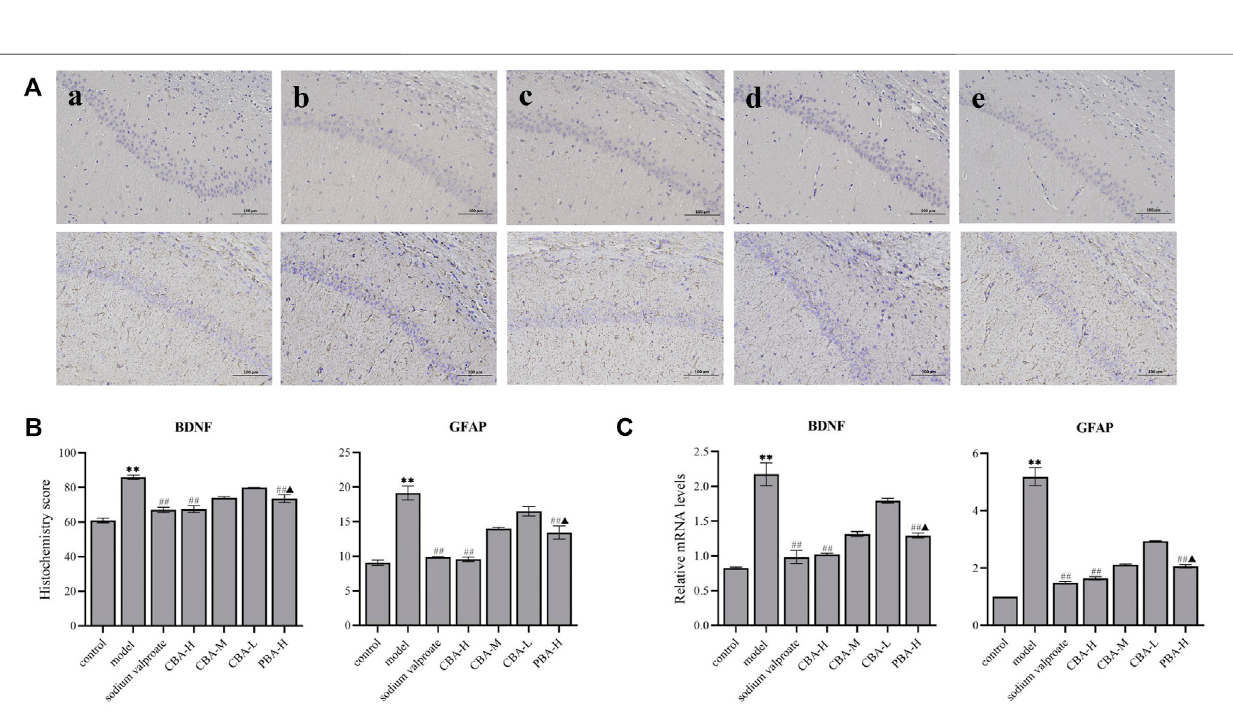
Frontiers in Pharmacology |